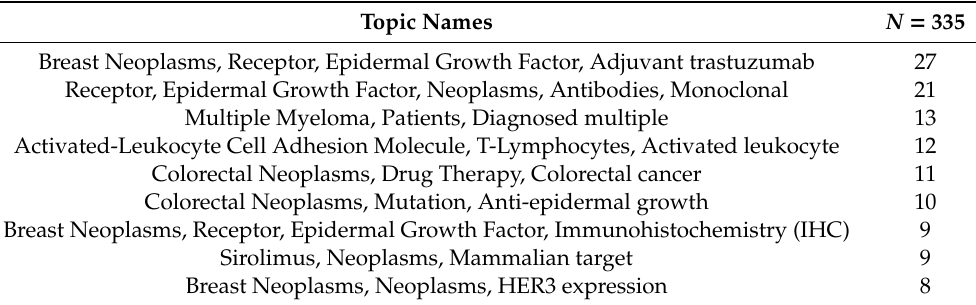
Table 6. Neoplasms. Cluster (9), weigh 11.58%. Topic